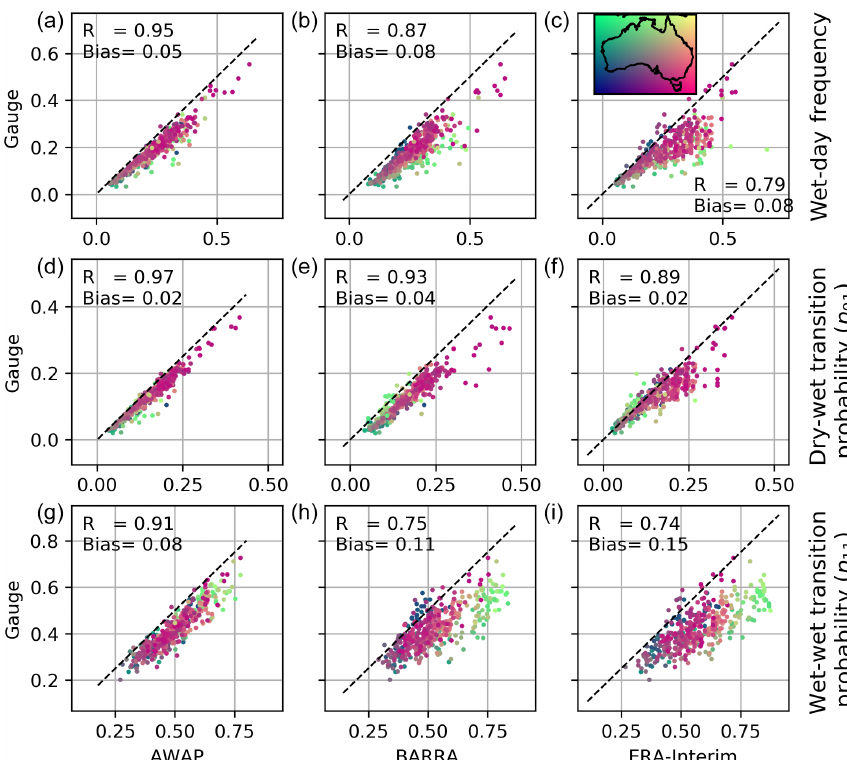
Figure 4. Wet-day frequency estimates from gridded datasets (AWAP, BARRA, and ERA-Interim) and observations at gauge loca- tions (a, b, c) . Transition probabilities: dry–wet ( p 01 : d, e, f ) and wet–wet ( p 11 : g, h, i ). Colour of scatter indicates the location of the